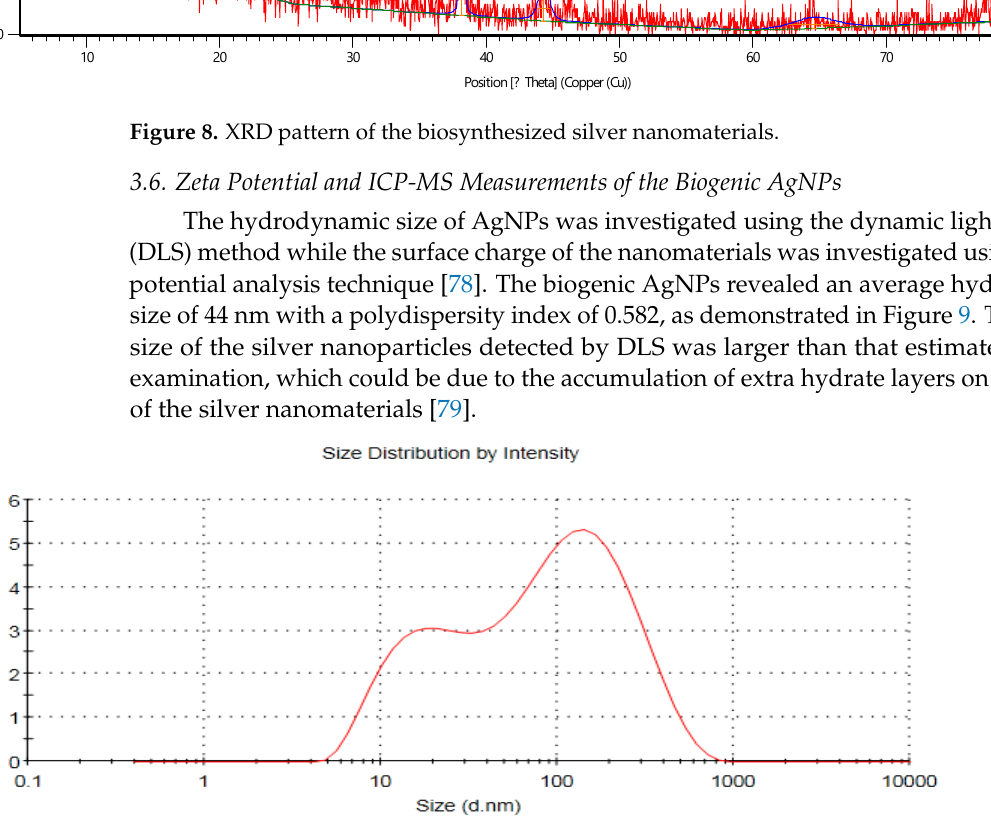
Figure 9. Dynamic light scattering pattern of the biosynthesized silver